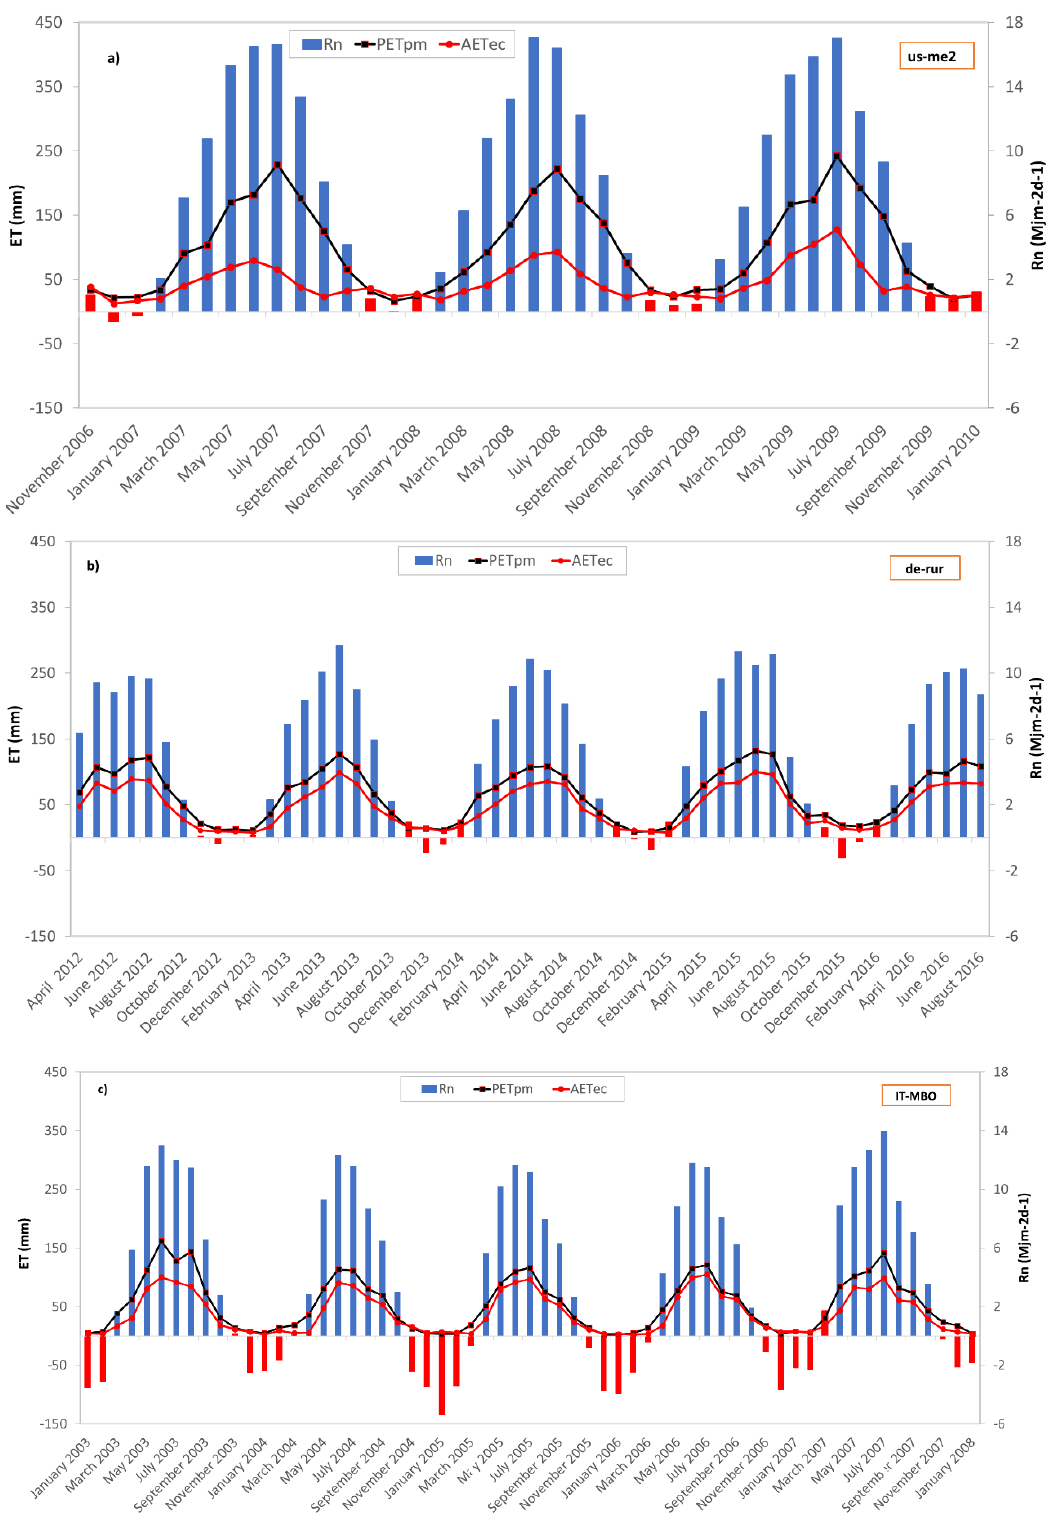
Figure 3. Monthly actual evapotranspiration, Penman potential evapotranspiration, and net radiation at the Sister site ( a ), the Rollesbroich site ( b ), and Bondone mountain ( c ) for the period under investigation. Red bars indicate net radiation values below the net radiation threshold.